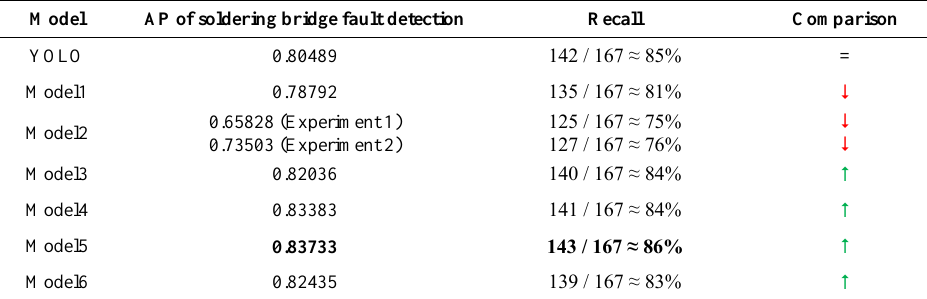
Table 2. Comparison of results for AP of soldering bridge fault